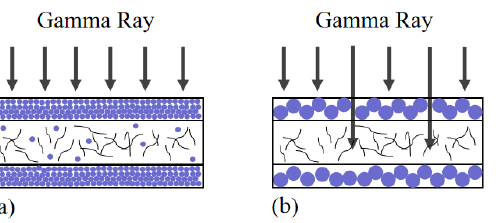
Figure 3. Schematic diagram of the sandwich structure: ( a ) nanometer ‐ sized WO 3 particles (small particles); ( b ) micron ‐ sized WO 3 particles (large particles).